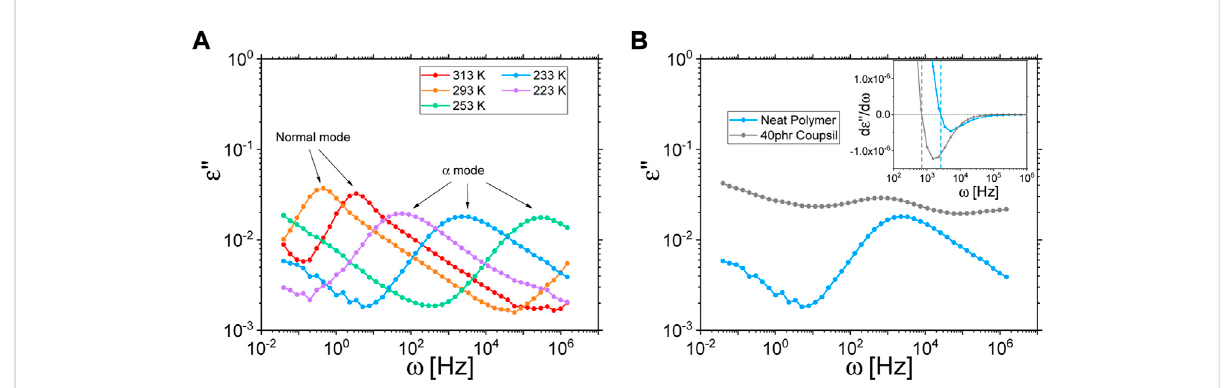
FIGURE 2 (A) Dielectric measurements of the neat deuterated polyisoprene at different temperatures. (B) Comparison of the dielectric response at 233 K of the polymer matrix and a composite sample ( fi lled with 40 phr Coupsil particles). Inset: fi rst derivative of the dielectric permittivity. Vertical dashed lines indicate the frequencies at which the derivative equals